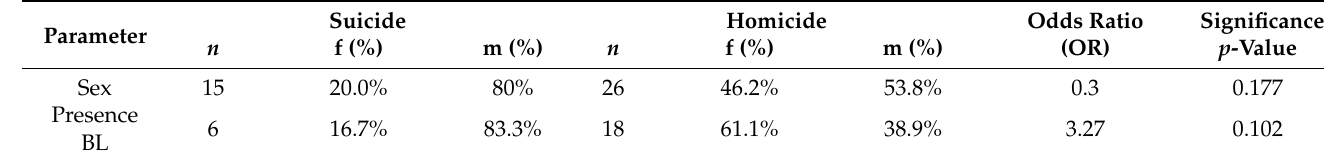
Table 9. Odds ratios and p -values of Fisher’s exact tests.